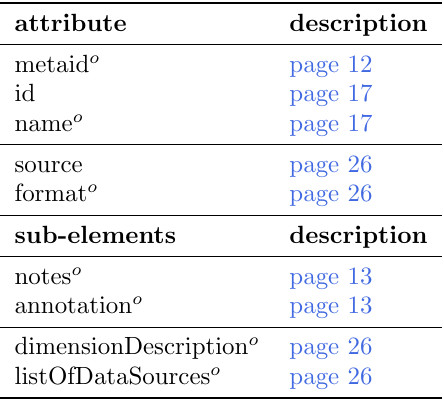
Table 2.6: Attributes and nested elements for dataDescription. o denotes optional elements and